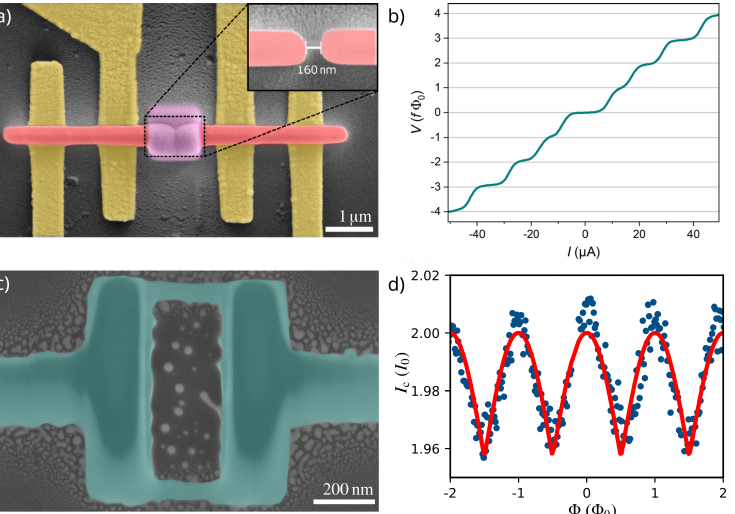
Figure 8. ( a ) SEM image of a W-C SNS-JJ fabricated by a single-step, direct write FEBID process. The superconducting leads (red) are deposited with a high electron beam current whereas the normal conducting part (purple) is deposited with a low electron beam current. Yellow represents the Au leads. ( b ) The current voltage characteristics of the SNS-JJ exhibiting the expected Shapiro